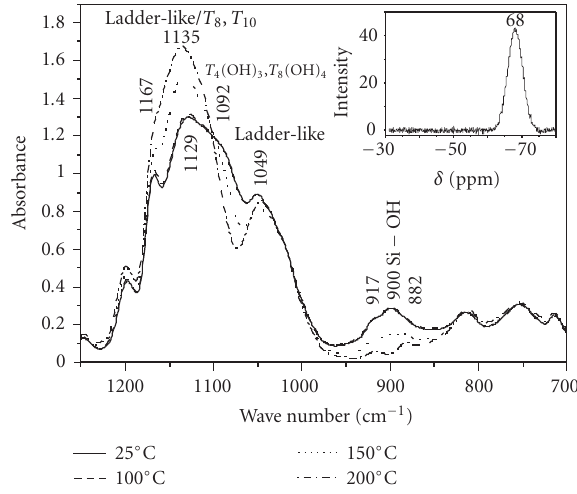
Figure 4: IR transmission spectra of hydrolyzed MTMSPI + I − aged 4 months and then was heat treated at various temperatures. Inset: 29 Si NMR spectrum of heat-treated (200 ◦ C) sample.